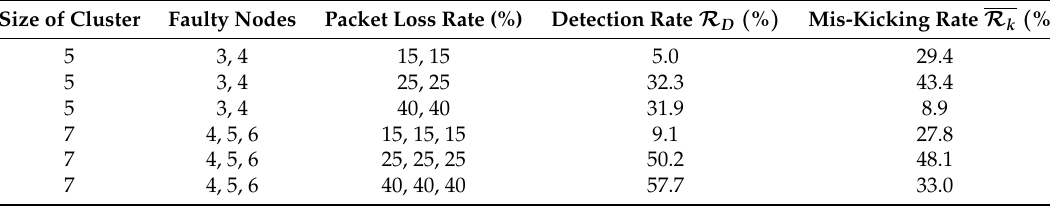
Table 8. The system-level testing results with the original AutoDown mechanism of Akka. Each group is tested for 6 h